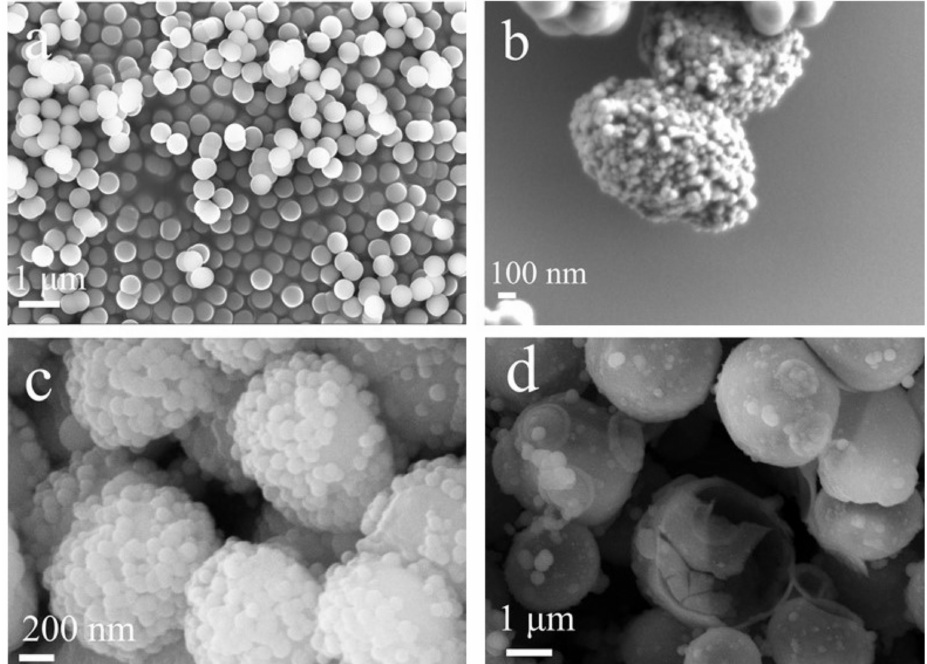
Figure 1. SEM images of SiO 2 prepared by different preprocessing methods: ( a ) without adding template; ( b ) P. pastoris GS 115 were suspended in ethanol and followed by TEOS and ammonia; ( c ) P. pastoris GS 115 were suspended in a hybrid system of ethanol and ammonia and followed by TEOS and ammonia; ( d ) P. pastoris GS 115 were suspended in an ethanol–water mixture and followed by TEOS and